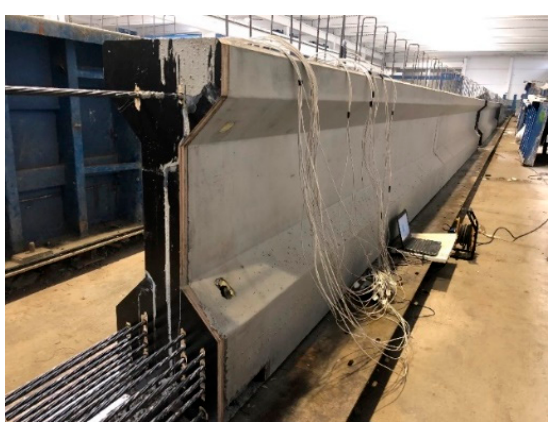
Figure 9. General view of the test setup prior to strand release.